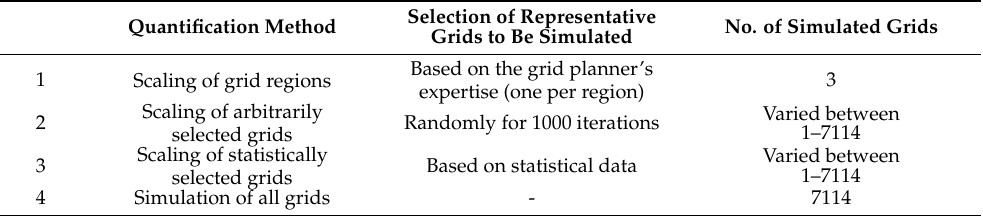
Table 4. Evaluated methods to quantify future grid reinforcement